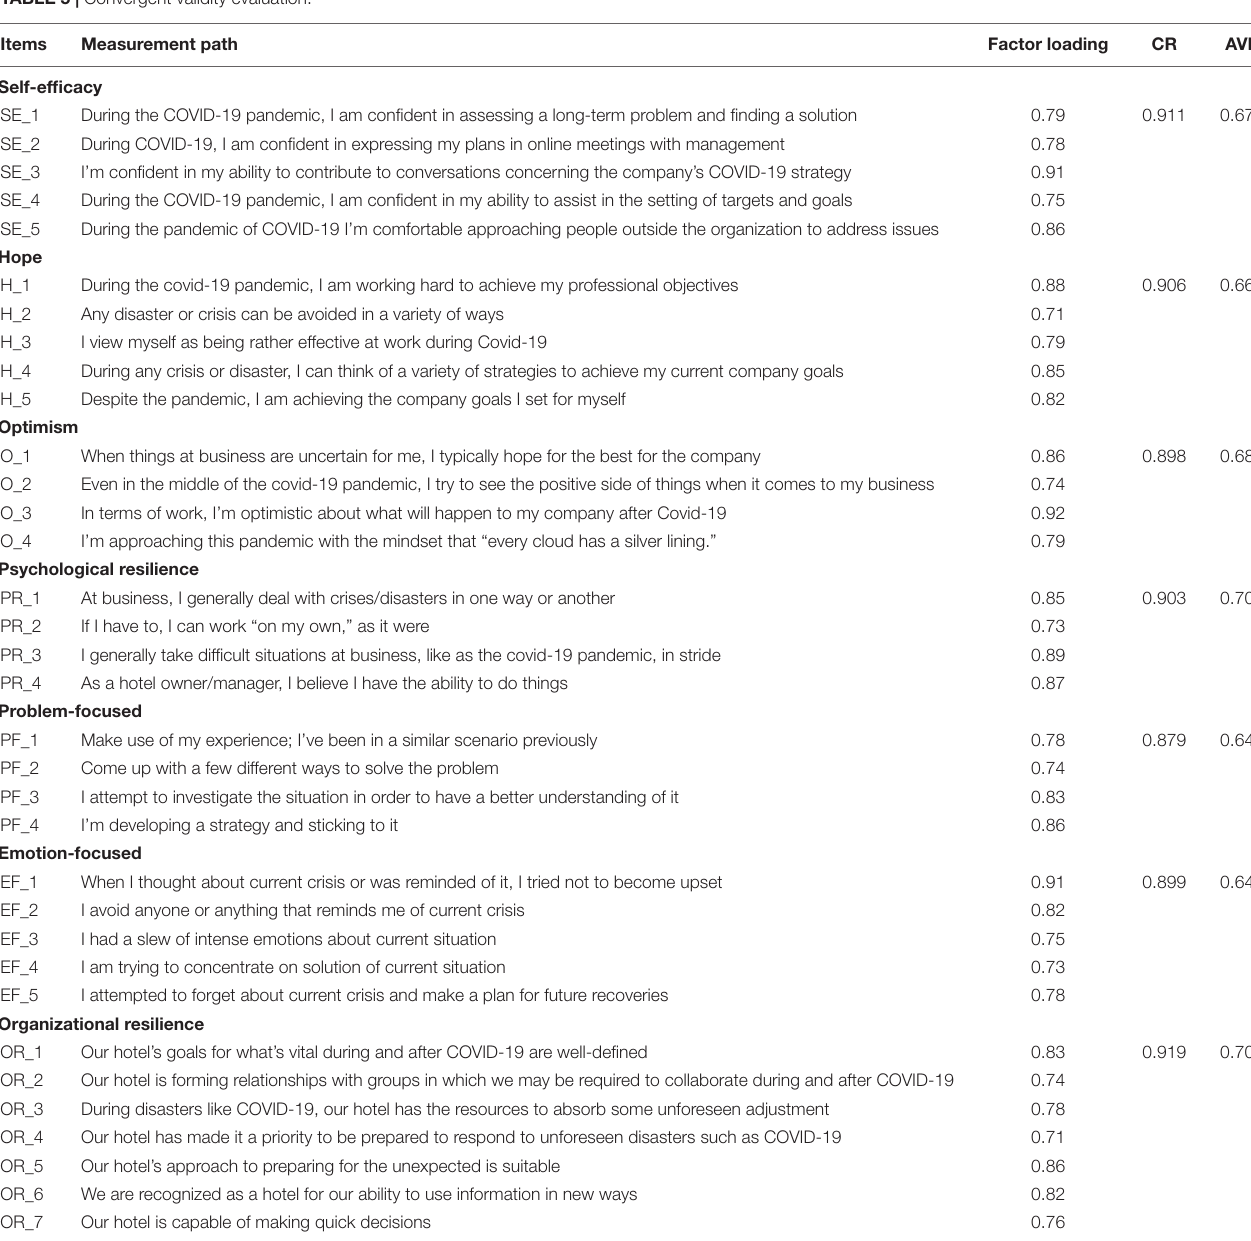
TABLE 5 | Convergent validity evaluation. Items Measurement path Factor loading CR AVE